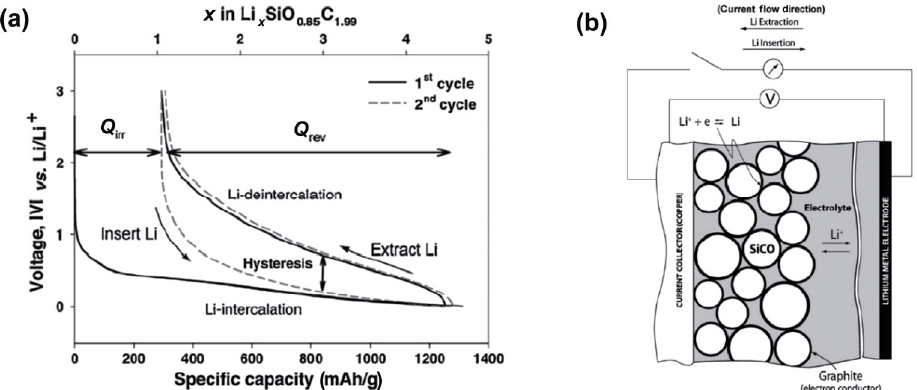
Fig. 19 (a) Insertion and extraction of lithium into polymer-derived SiOC and (b) a scheme of the microstructure of the SiOC electrode during cycling. Reproduced with permission from Ref. [444], © Elsevier B.V.